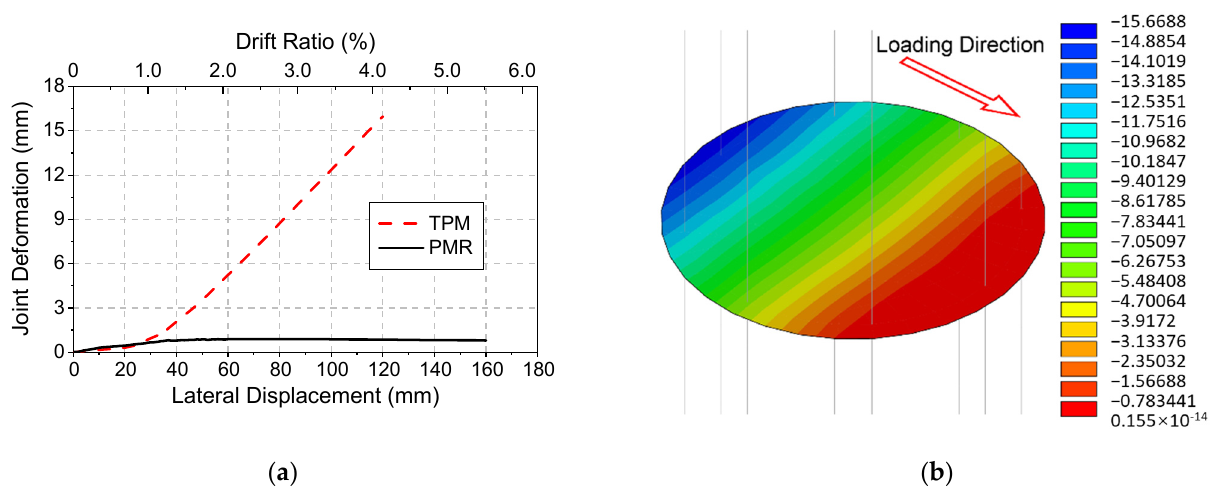
Figure 15. TPM’s ( a ) joint deformation curves; ( b ) gap distance of at the displacement of 120 mm. (unit: mm).